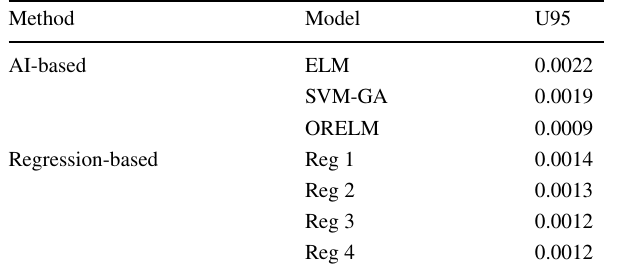
Table 2 Results of 95% uncertainty for artificial intelligence and regression models Method